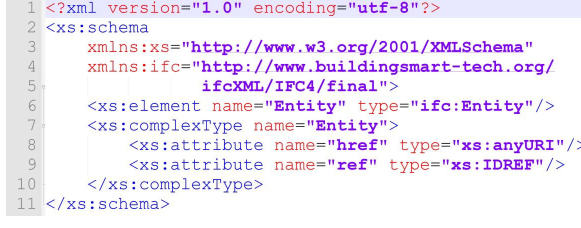
Figure 2. An example of ifcXML XSD structure used in the experiment. Here line 6-9 represents XSD Constructs C 1 - C 4 respectively.